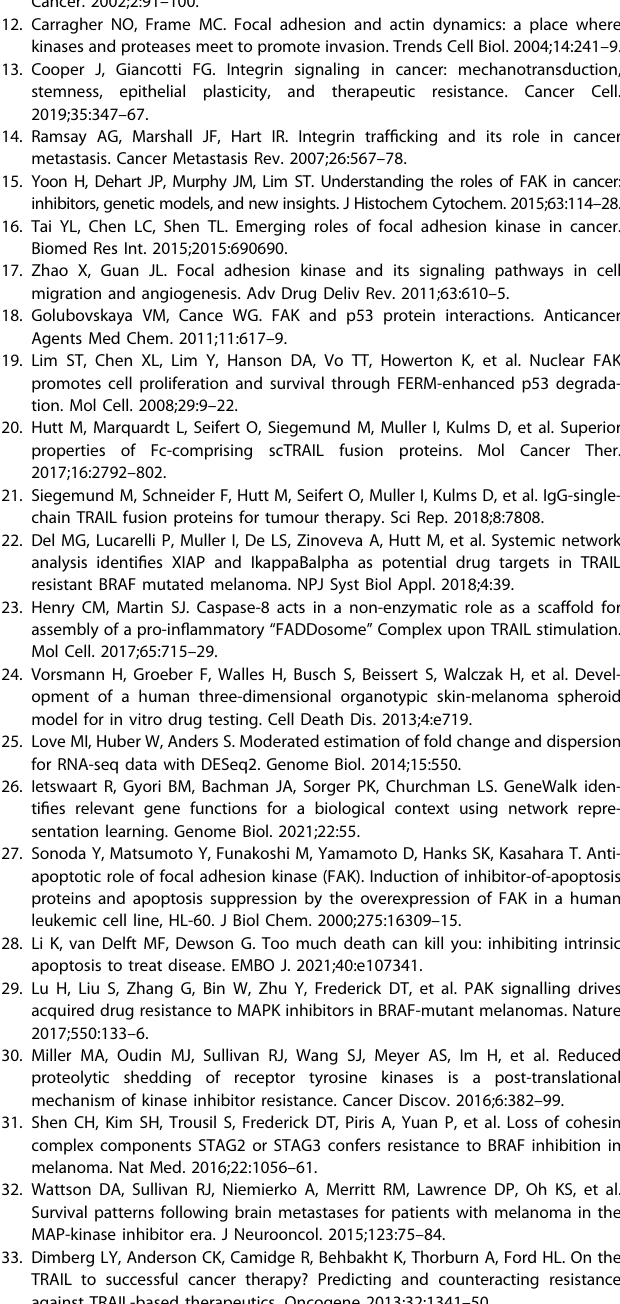
Fig. 8 FAK inhibition sensitizes resistant mut BRAF and mut NRAS melanoma to mutation-speci fi c targeted kinase inhibition. A Parental mut BRAF Malme3M and WM3248 MM cells were conditioned to 1 µM BRAF inhibitor dabrafenib (Dabra); mut NRAS SkMel2 and SkMel147 cells to 1 nM MEK inhibitor trametinib (Trame). mut BRAF parental (p) and conditioned (c) cells were treated with 10 µM dabrafenib, dabrafenib + 1 µM trametinib, 2.5, 5, or 10 µM of the iFAK defactinib alone and in combination with 10 µM dabrafenib. Parental (p) and conditioned (c) mut NRAS cells were treated with 1 µM trametinib, trametinib + 10 µM dabrafenib, 2.5, 5 or 10 µM of the iFAK defactinib alone and in combination with trametinib. Cell death was monitored by PI (1 µg/ml) uptake using IncuCyte ® live-cell analysis for 48 h. B Three mut BRAF (M45, M53, M59) and three mut NRAS (M10, M20, M32) cell samples freshly isolated from patients with relapsed melanoma metastases were treated as in A according to their mutation status. Cell death was monitored by PI (1 µg/ml) uptake using IncuCyte ® technology for 48 h. C The same patient-derived metastatic cell samples as in ( B ) were treated with IZI50, 2.5, 5, or 10 µM of the iFAK defactinib alone and in combination with IZI50. Cell death was monitored by PI (1 µg/ml) uptake using IncuCyte ® technology for 48 h. For each experiment n = 3 is shown (* p